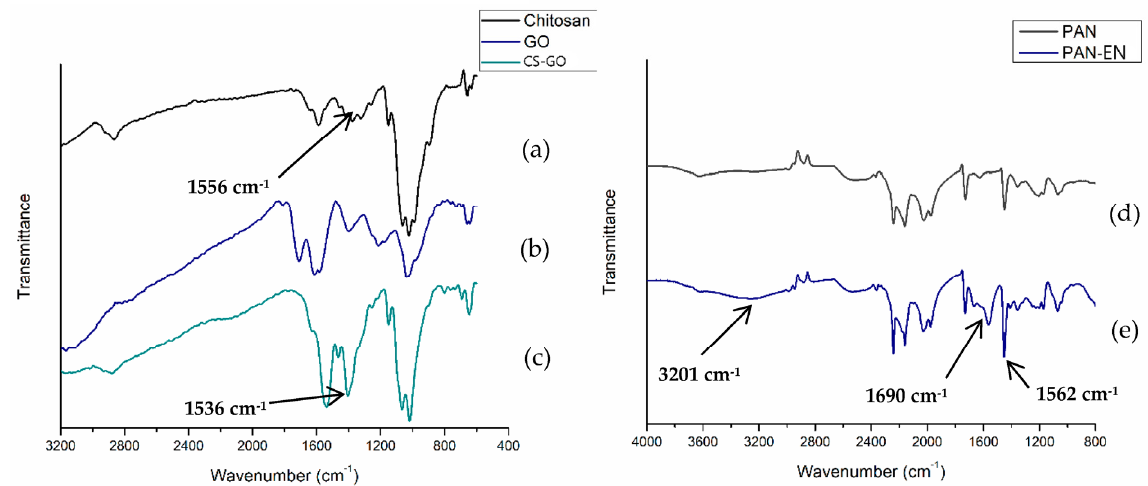
Figure 3. FT − IR spectra of ( a ) CS, ( b ) GO, ( c ) CS-GO membrane, ( d ) PAN and ( e ) PAN-EN electrospun nanofibers.